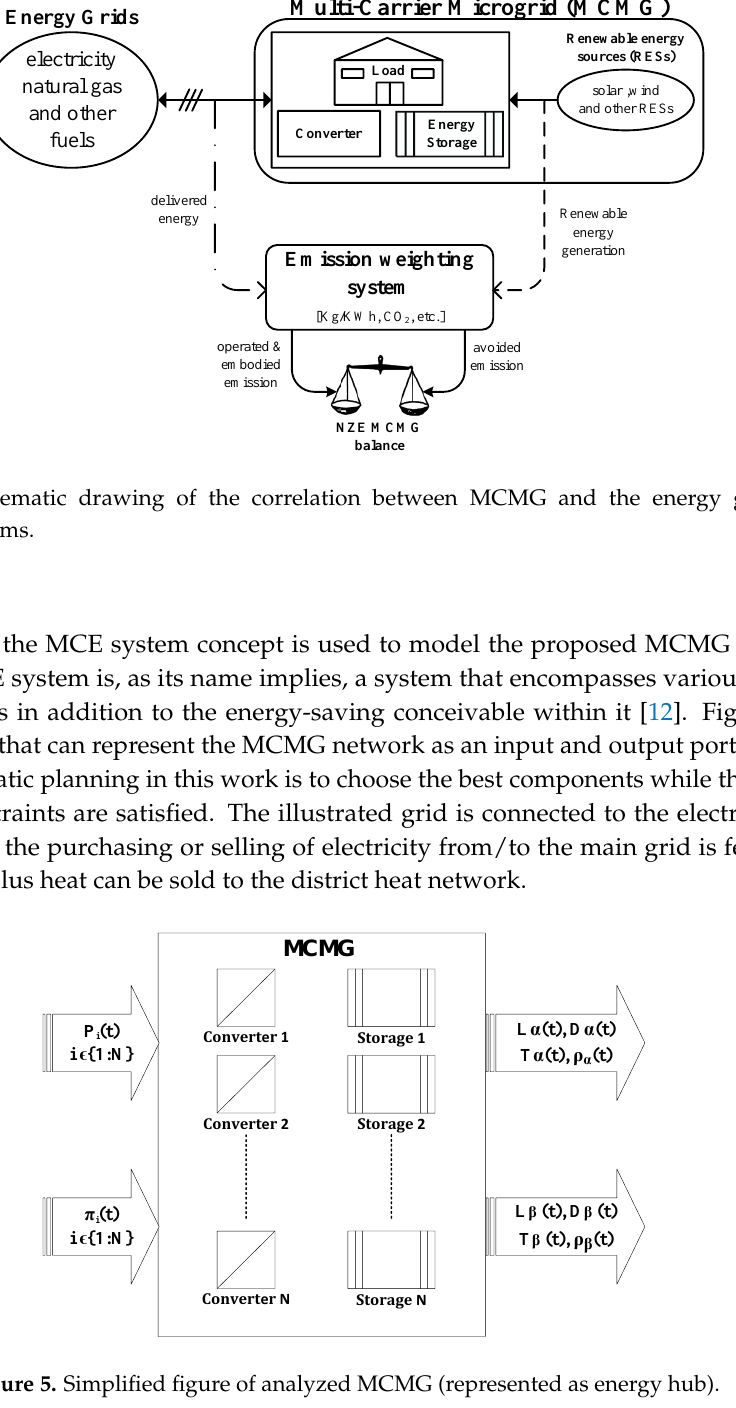
Figure 5. Simplified figure of analyzed MCMG (represented as energy hub).